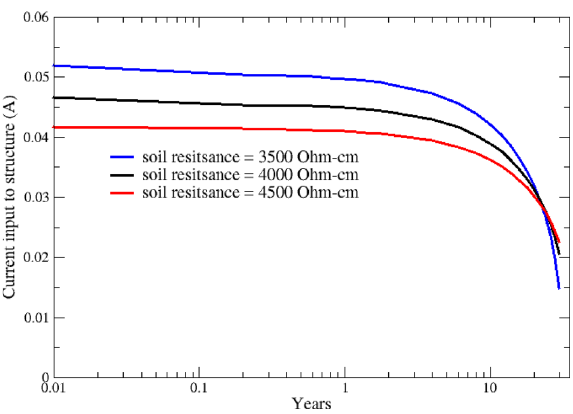
Figure 7. Variation of cathodic protection current at the screw pile over 30 years.